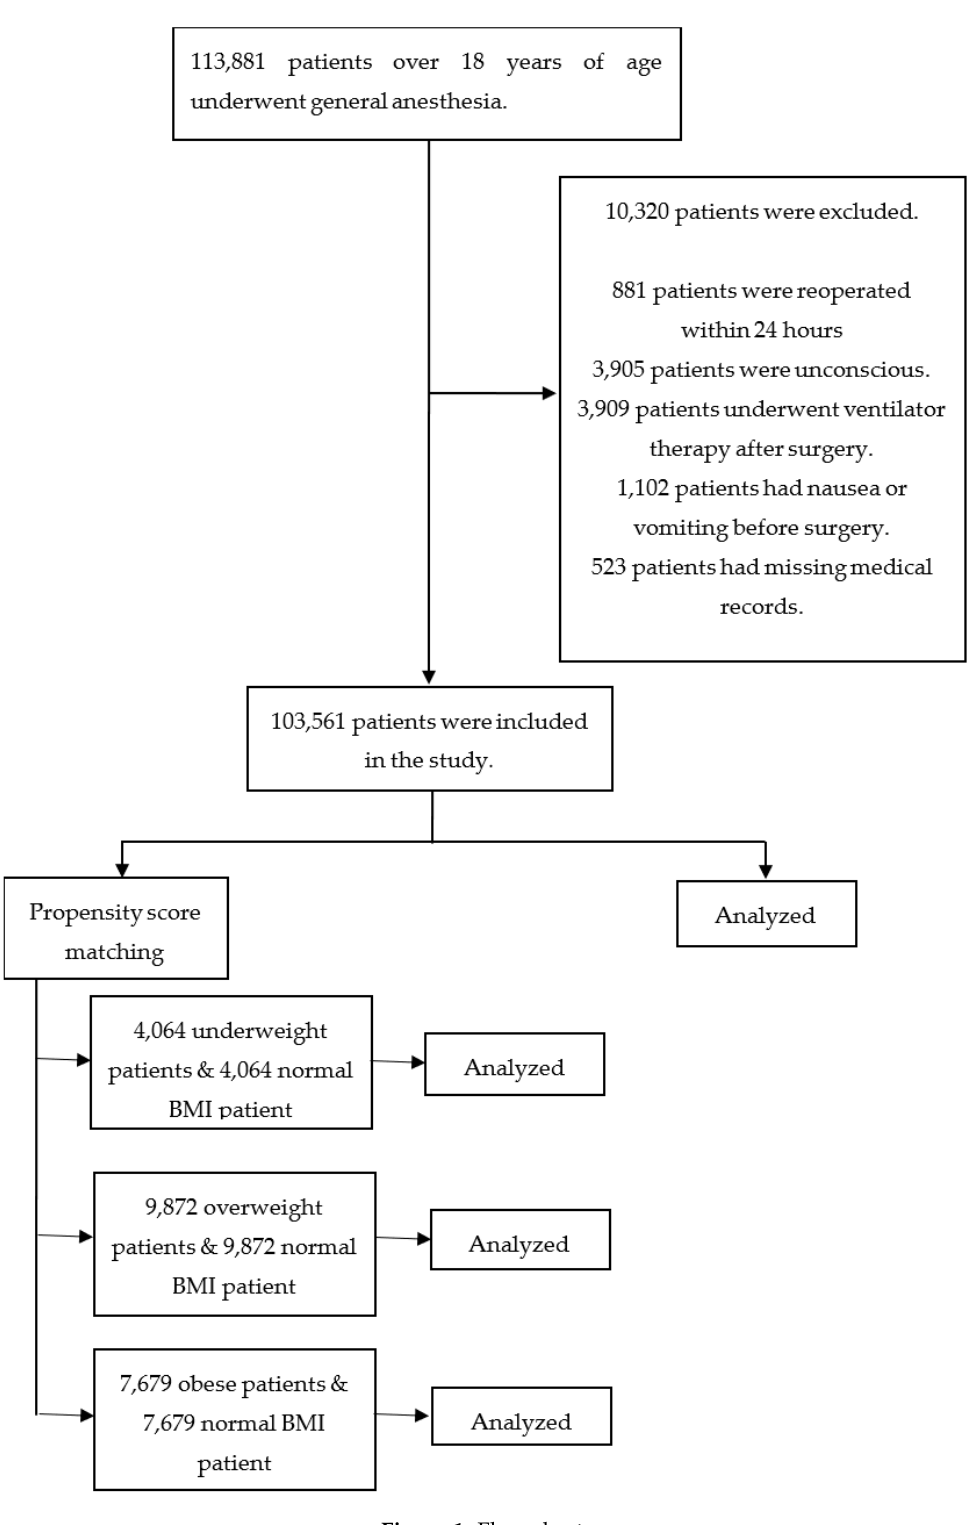
Figure 1. Flow chart.